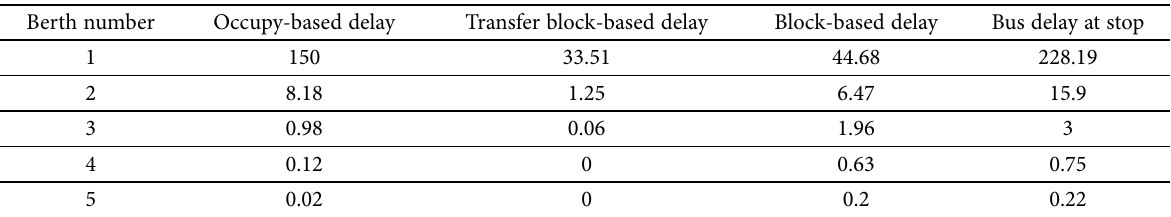
Fig. 7. The impact of service time on bus delay Table 2. The impact of berth number on bus delay ( arrival rate = 54 buses per hour, service time = 50